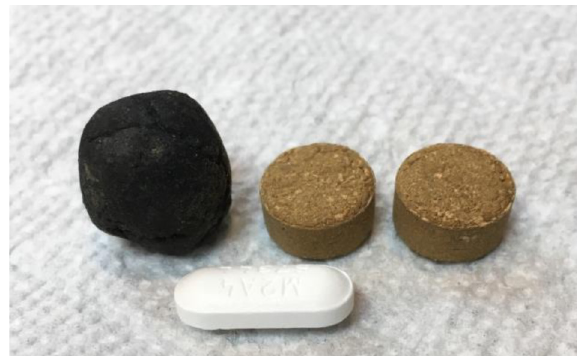
Figure 1 . Examples of “Khmer traditional medication” with possible admixture of prescription medication. (Acetaminophen caplet for size